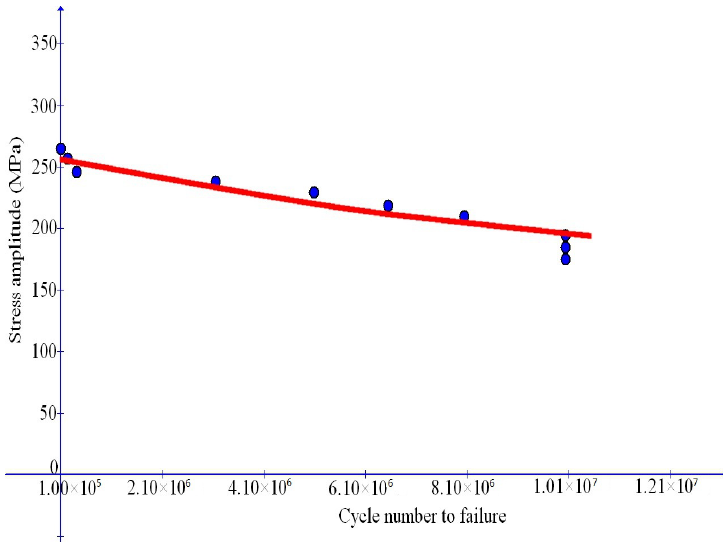
Figure 8. Comparison of simulation results with fatigue failure data (dots) from Sivananth et al. [7] for Al-matrix composite with 10% (wt) TiC reinforcing particles.